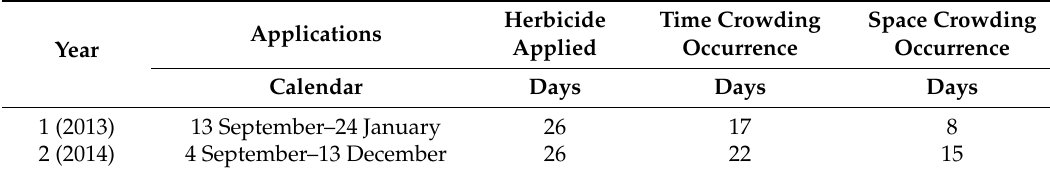
Herbicide Time Crowding Space Crowding Applied Occurrence Occurrence